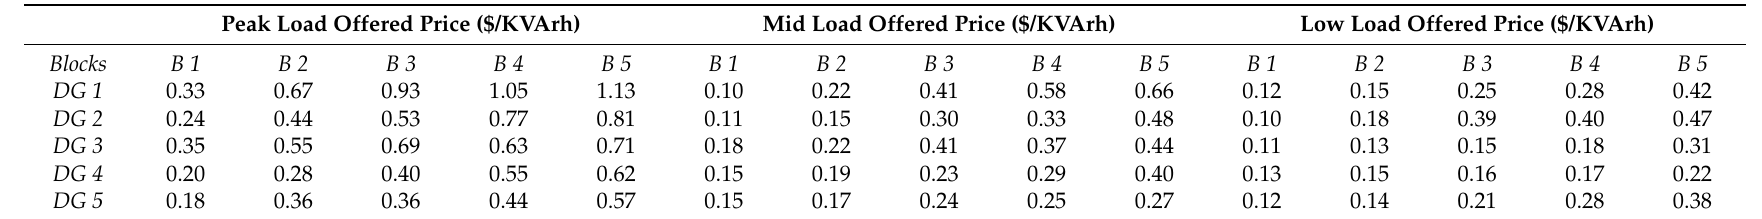
Table 4. Data of DGs’ offered price blocks for reactive power.